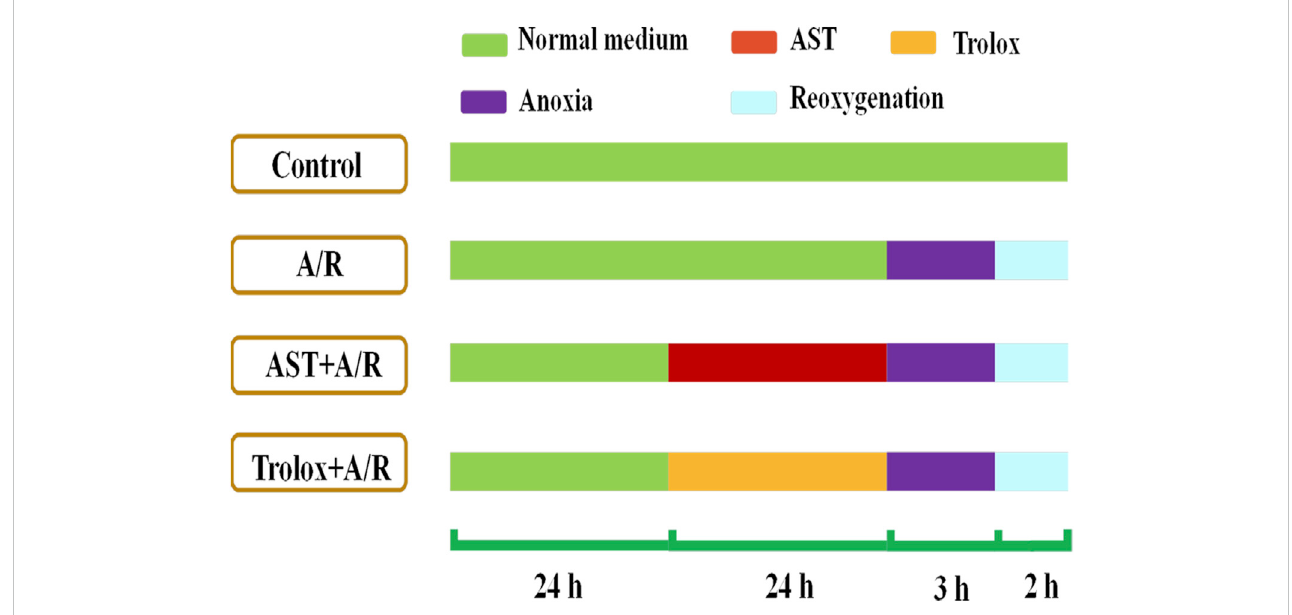
FIGURE 1 Astaxanthin pretreatment scheme. Cardiomyocytes were pretreated with astaxanthin (AST, 0.313 – 5 μ M) for 24 h before A/R injury.